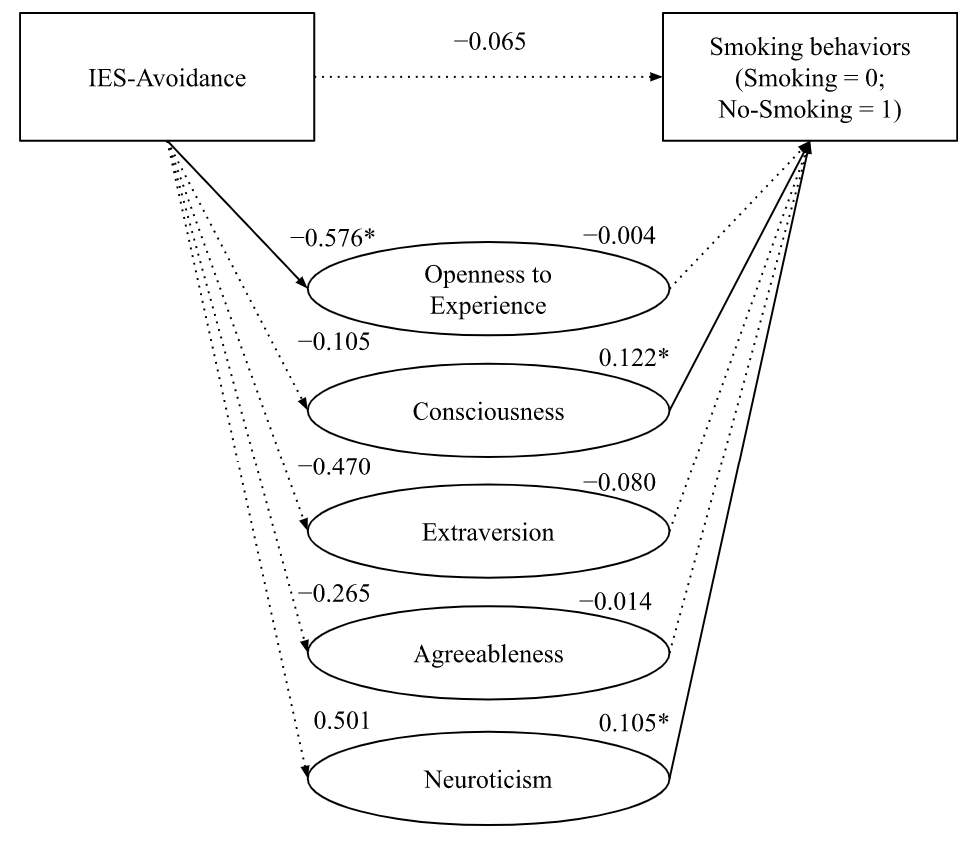
Figure 4. Partial mediation effect of personality on the relationship between avoidance and smoking behaviors. Note : * p < 0.05. Table 3. Bootstrapped indirect effects of the association between the impact of cancer, EI, person- ality traits, and smoking behaviors.